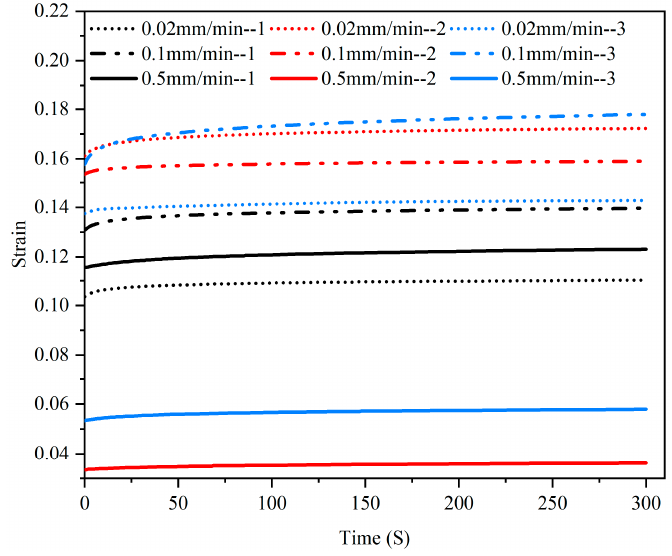
Figure 10. Creep strain–time curves of three samples at different rates.